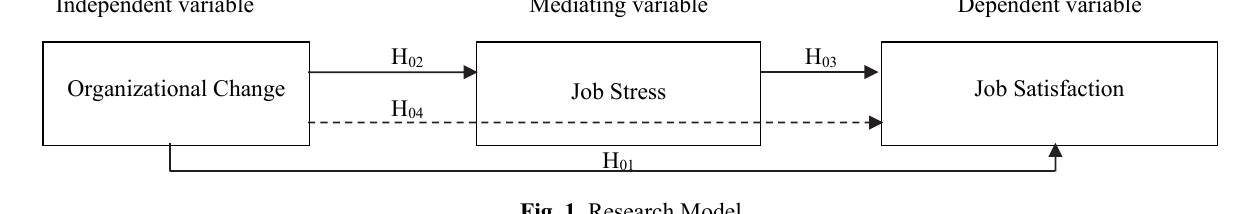
Fig. 1. Research Model